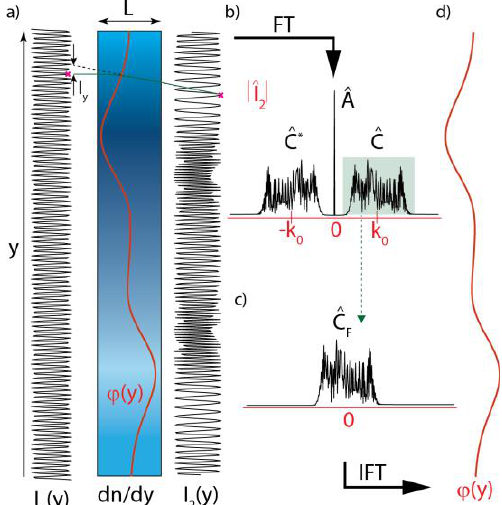
Fig. 2. Principle of the fringe projection technique in 1D (along y-axis): a) fringe pattern before I1 and after I2 propagation through the nonhomogeneous media; b) the Fourier amplitude spectrum of the fringe patter; c) the Fourier amplitude spectrum after a band-pass filtering and shifting; d) phase distribution retrieved from filtered complex field